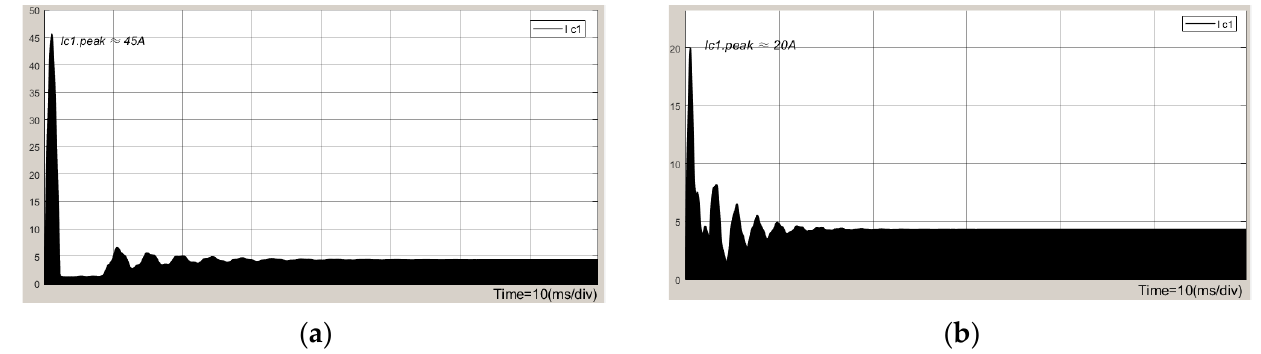
Figure 12. Capacitor charging spike current waveform: ( a ) current without thermistor in series; ( b ) current with thermistor in series.